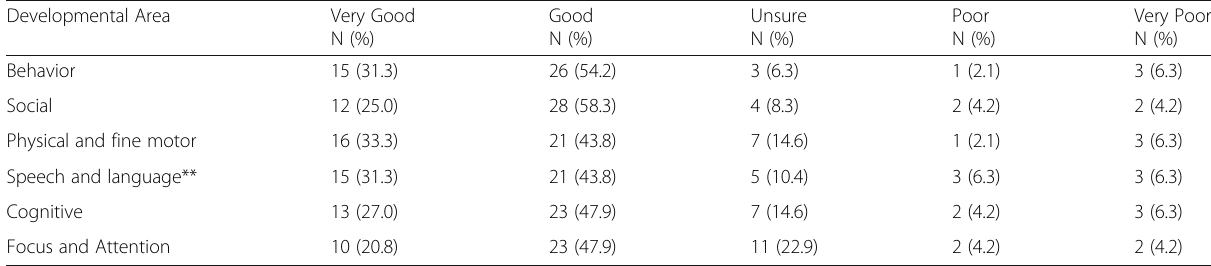
Table 3 Responses of parents in rating their child ’ s progress across developmental areas Developmental Area